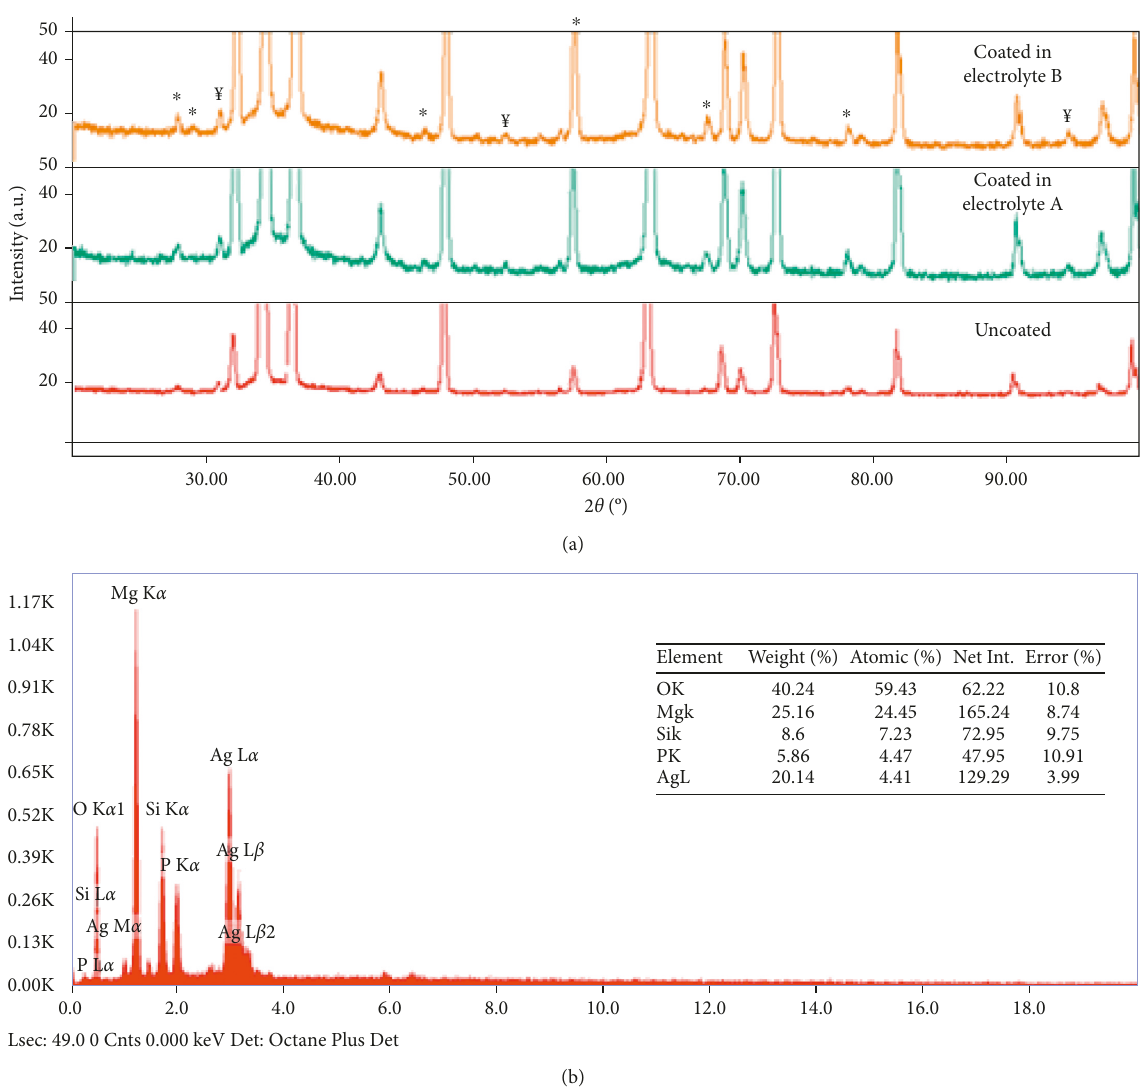
Figure 2: (a) XRD patterns and (b) EDS patterns of the coated and uncoated Mg samples.